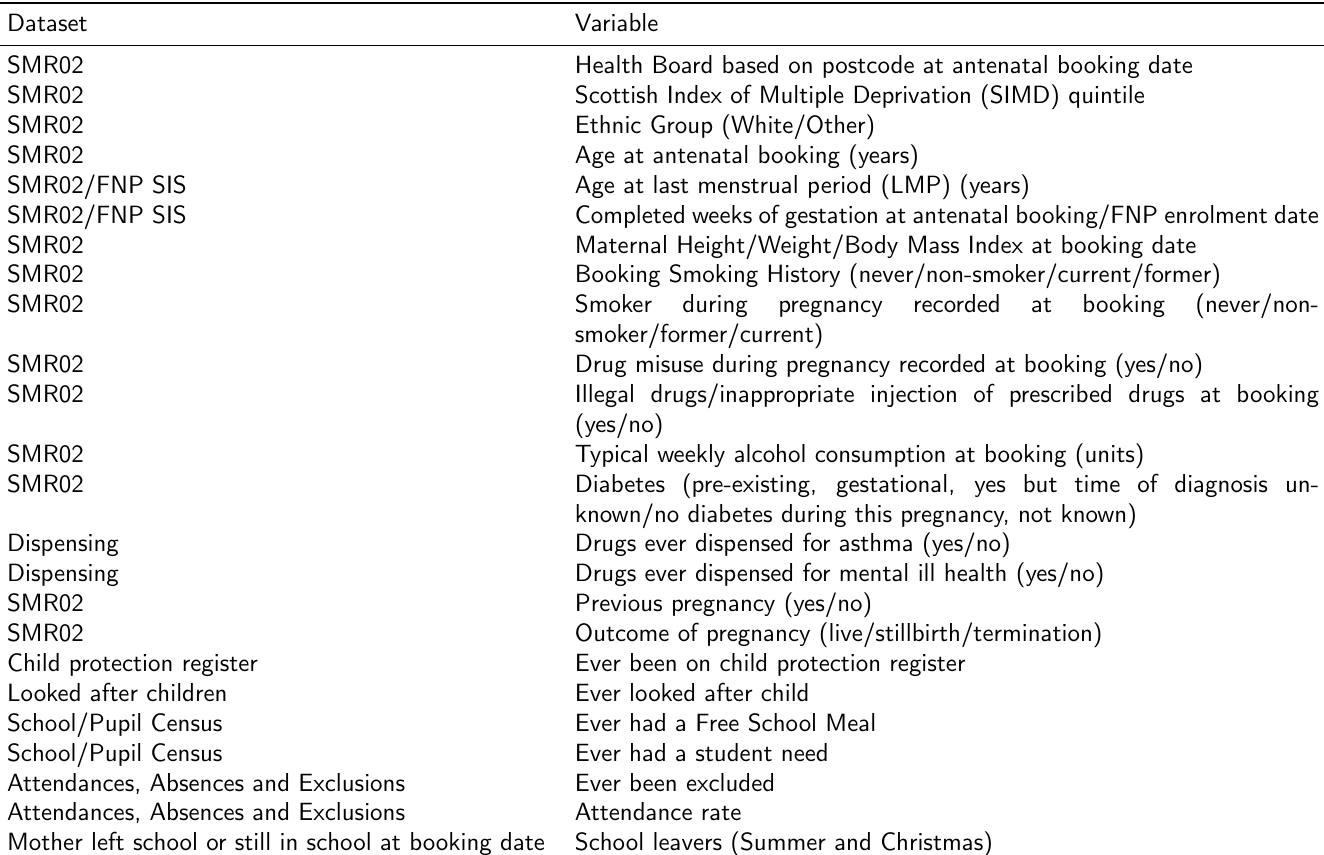
Table 4: Maternal baseline characteristics measured at (or before) date of antenatal